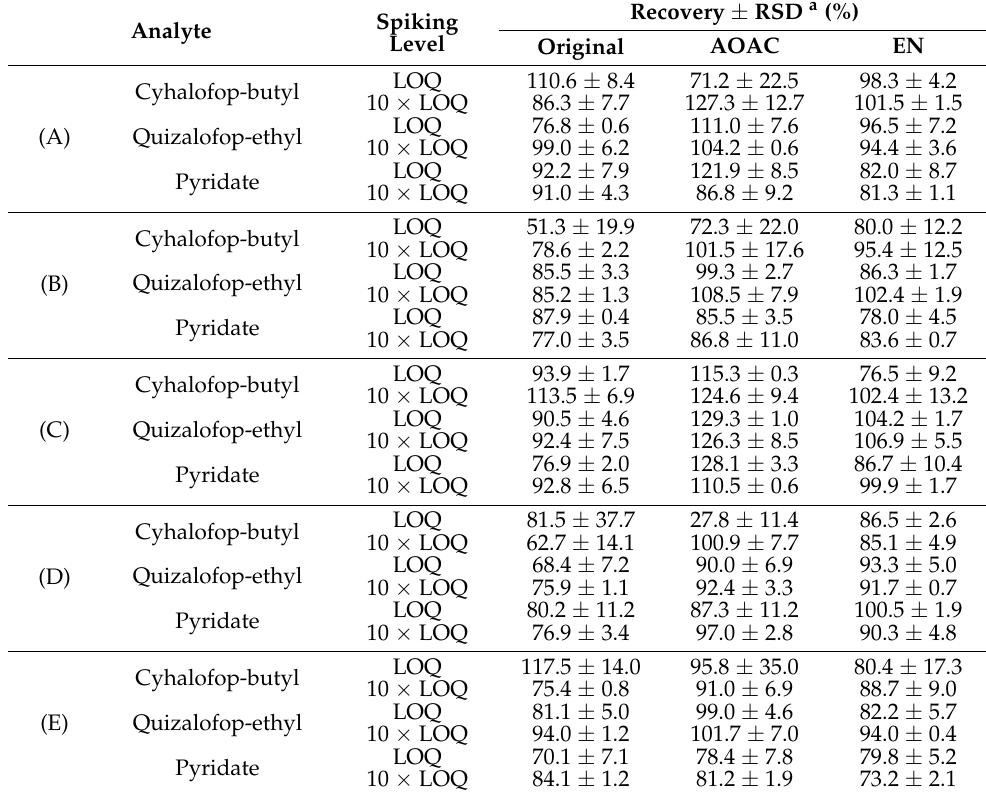
Table 3. Comparison of QuEChERS extractions for the determination of three residual herbicides